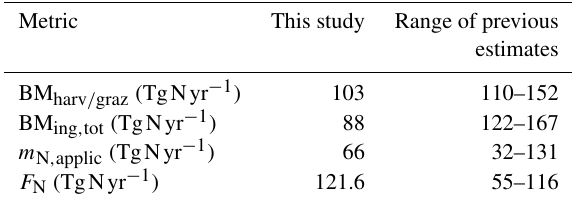
Table 8. Global estimates of intermediate variables computed by the model in this study for the 2005–2015 period and the range of previous